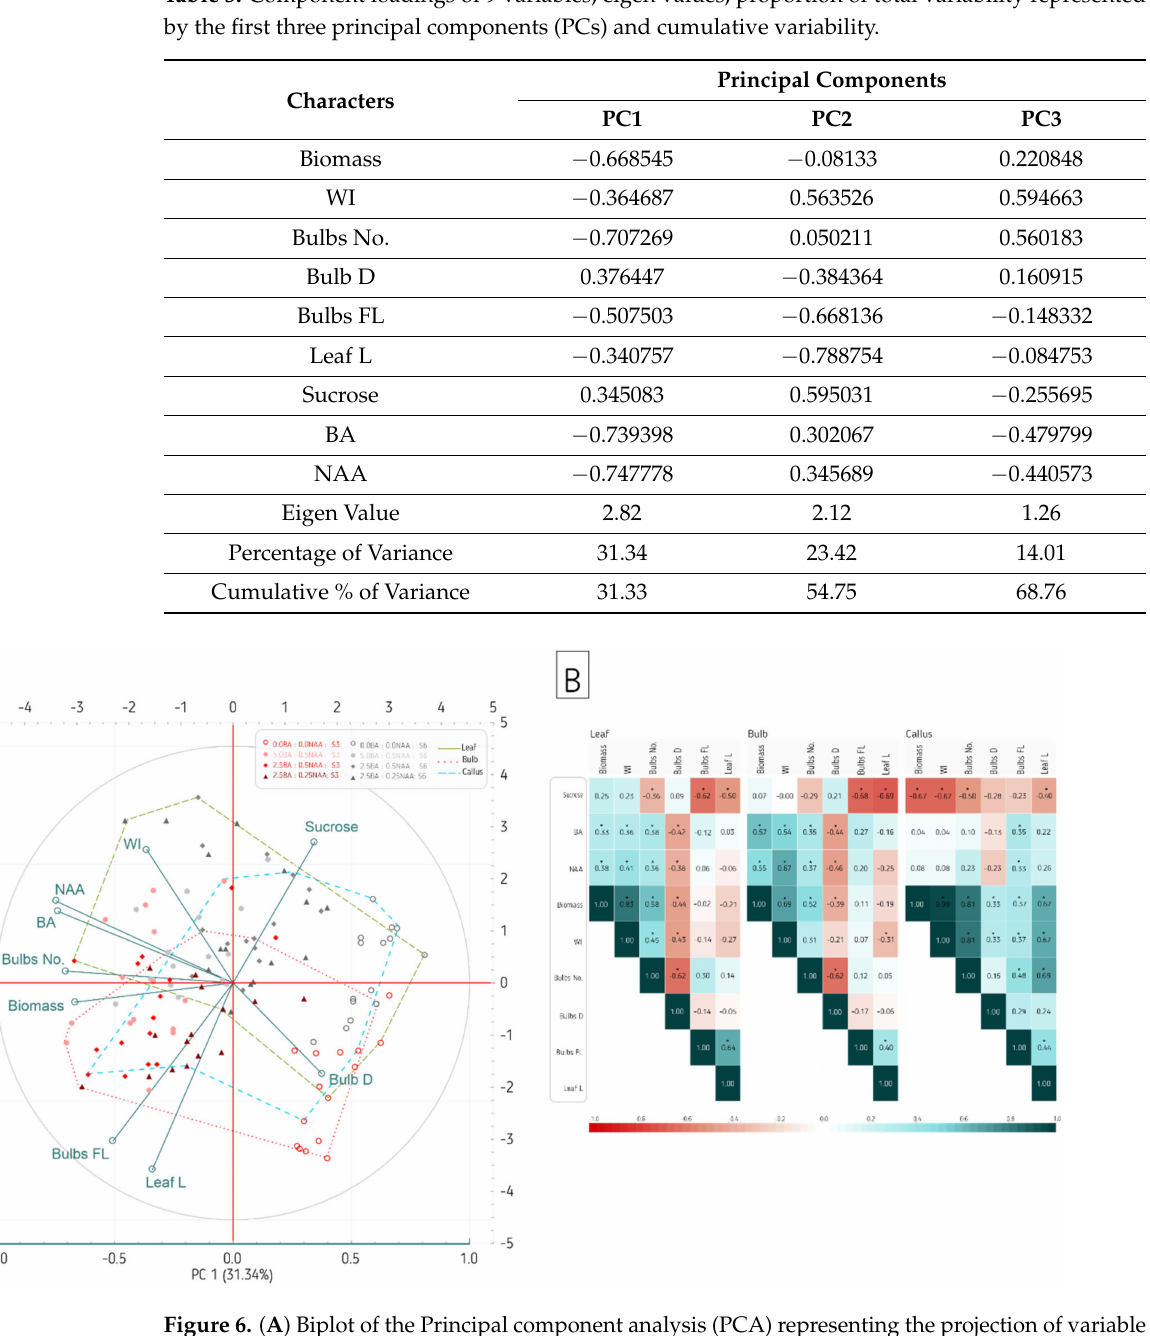
Figure 6. ( A ) Biplot of the Principal component analysis (PCA) representing the projection of variable vectors and observation points on the plane defined by the first two PCs, showing